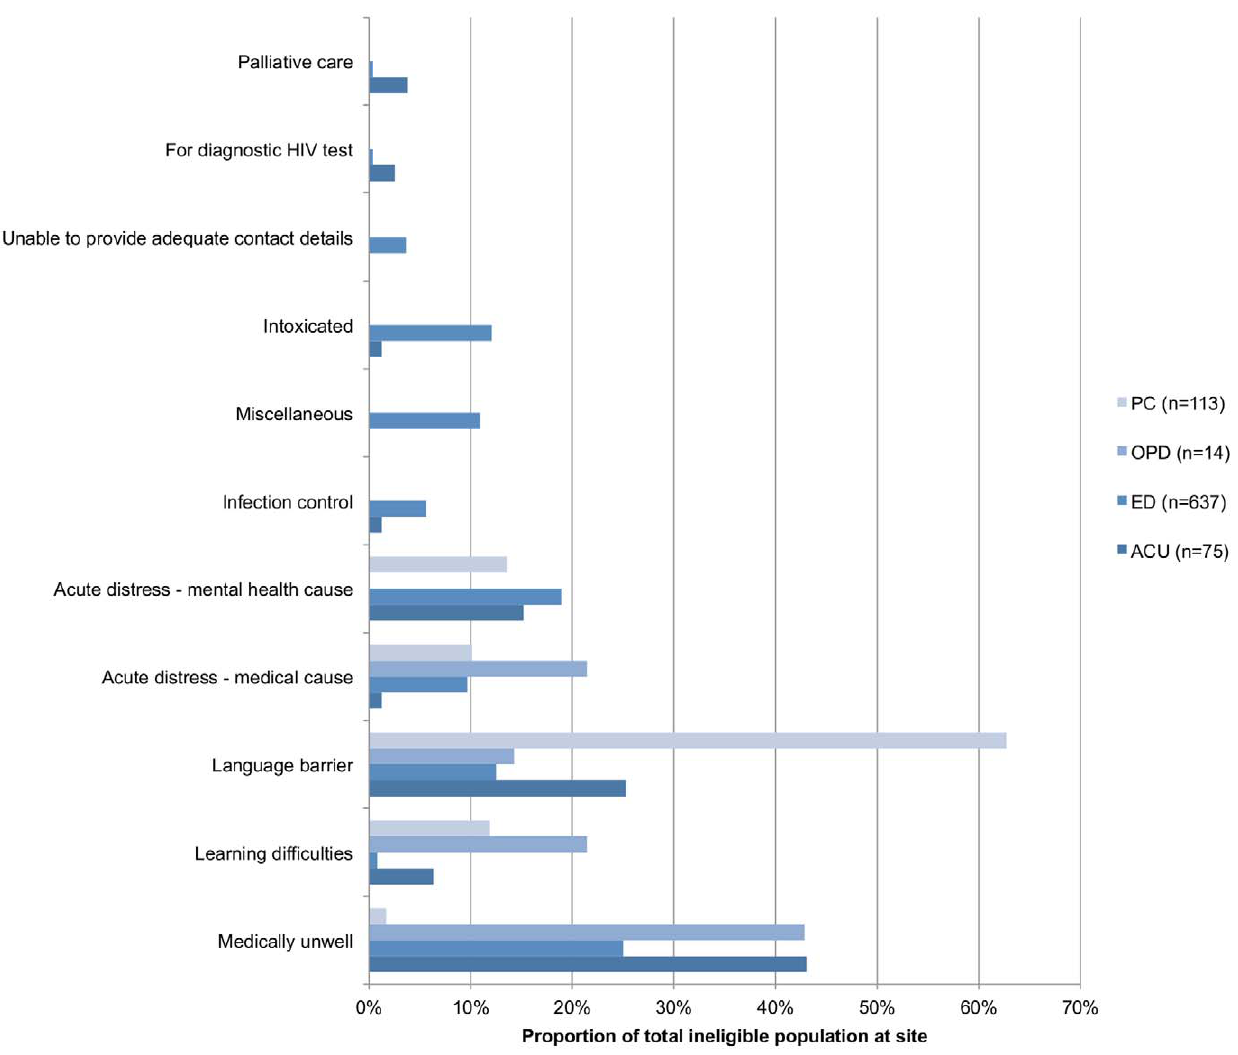
Figure 1. Reasons for clinical ineligibility to participate by site (proportion of total ineligible (%)).